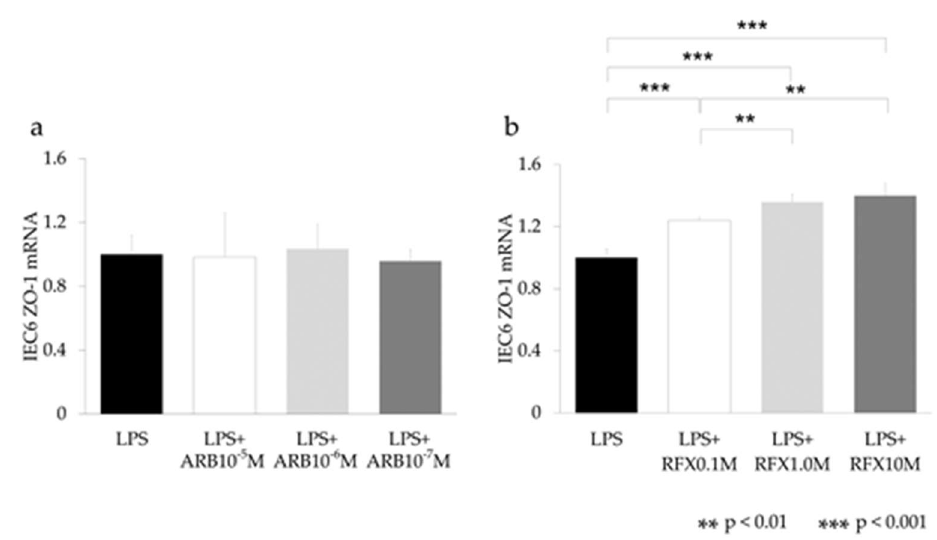
Figure 8. In vitro study of the ZO-1 expression on intestinal epithelial cells using IEC-6. ( a ) ARB, ( b ) RFX. ARB did not increase ZO-1. RFX increased ZO-1 expression in proportion to the LPS concentration. ** p < 0.01, *** p < 0.001.